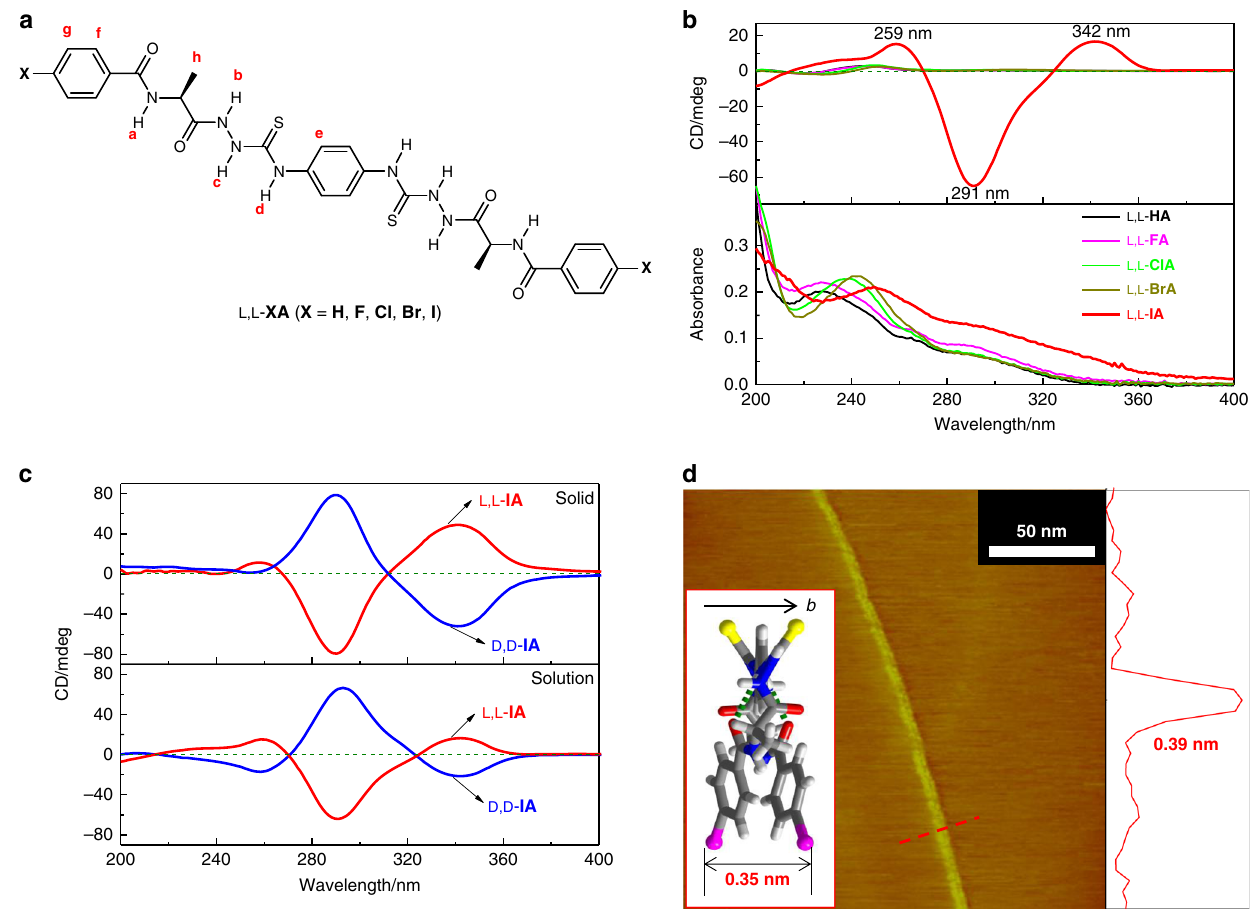
Fig. 3 Absorption and CD spectra. a Molecular structures of bilateral N -amidothioureas L,L- XA ( X = H , F , Cl , Br , I ) with labeled protons. b Absorption and CD spectra of L,L- XA in CH 3 CN. [L,L- XA ] = 5 μ M. c CD spectra of L,L- IA and D,D- IA in CH 3 CN solution and the solid state. For solution, [ IA ] = 5 μ M, while the concentration of the solid CD sample is about 1.0 mg/400 mg KCl. d STM height image of L,L- IA at the CH 3 CN-HOPG interface with height pro fi le along the red dashed line. Inset is the thickness of single cis -L,L- IA molecule along b -axis revealed by the crystal structures. [L,L- IA ] = 1 μ